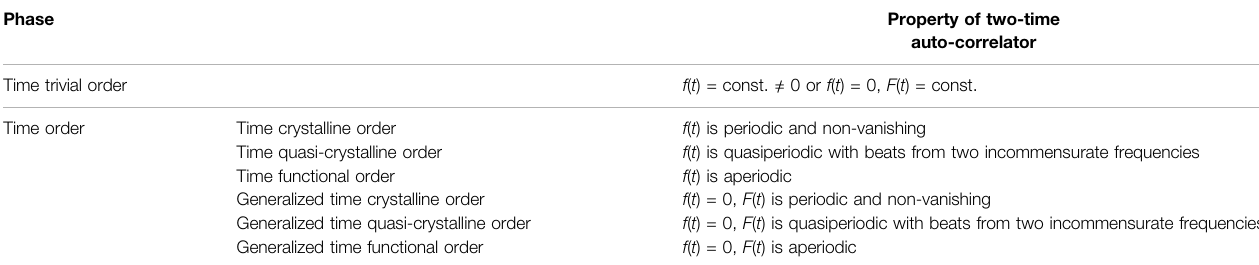
auto-correlator